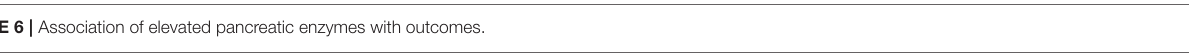
TABLE 6 | Association of elevated pancreatic enzymes with outcomes. Outcomes Patients with elevated ( n =